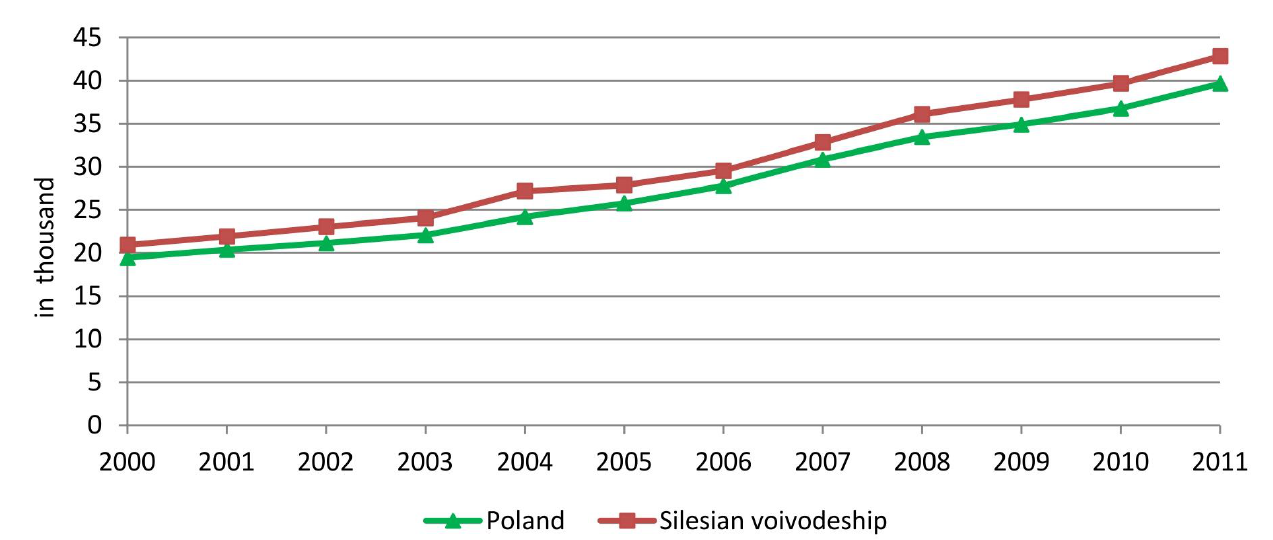
Fig. 1. Changes in the nominal GDP per capita in Poland and the Silesian voivodeship between 2000 and 2011 (in PLN at current